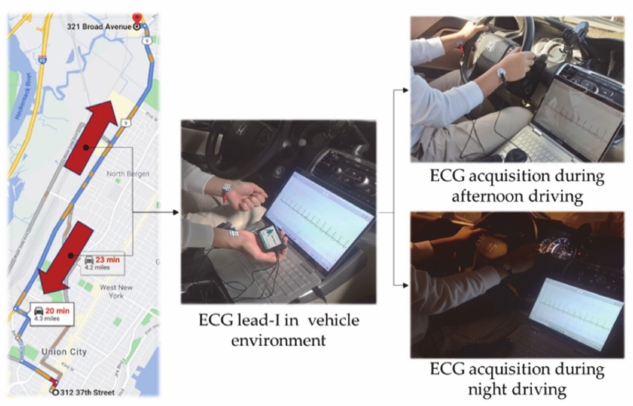
Figure 10. ECG lead-I acquisition in driving environment.